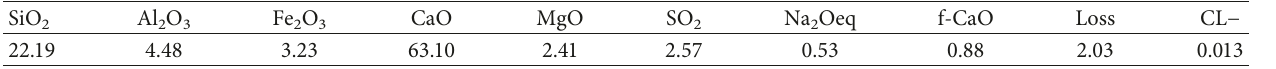
Table 1: Chemical components of the reference cement.